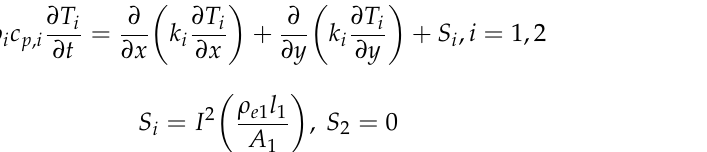
where ρ i , c p , i , and k i are the density, heat capacity, and thermal conductivity of Ag NPs and the glass substrate, respectively. The subscript i is the representation for each